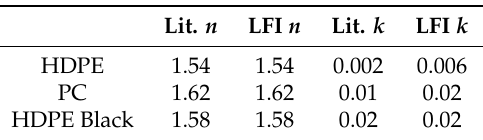
Table 1. Literature reference values and LFI estimated values for n and k for the three homogeneous plastics. For source of literature values see